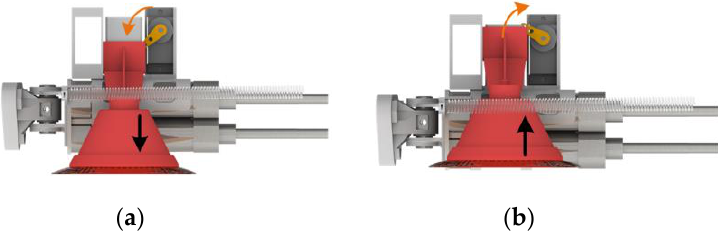
Figure 2. The position of the feet under the control of the miniature motor: ( a ) the feet are lowered down when the segment is stationary; ( b ) the feet is lifted up before the segment’s motion starts.